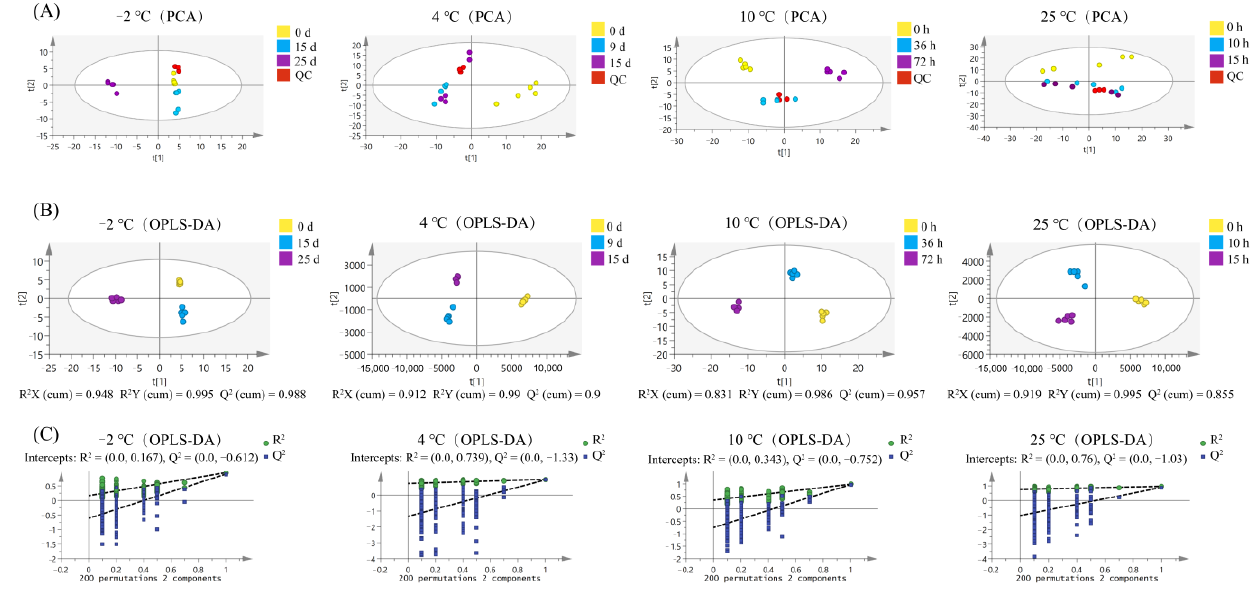
Figure 2. PCA ( A ), OPLS-DA ( B ), and permutation test ( C ) of pork meat identified peptides at different time points under storage at − 2, 4, 10, and 25 °C.